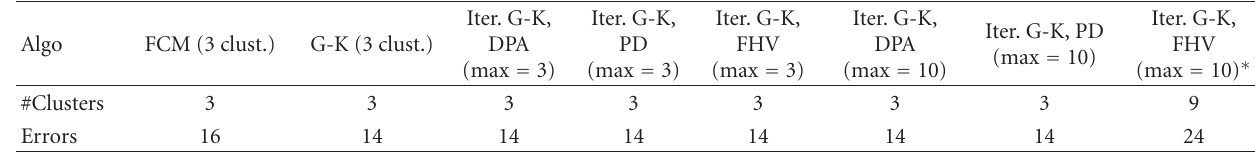
Table 2: Number of resultant Iris clusters and classification errors from each of the three algorithms using two di ff erent maxima for the iterative algorithm. ∗ Number of errors from clustering of 9 resultant subclusters using FHV, max = 3.